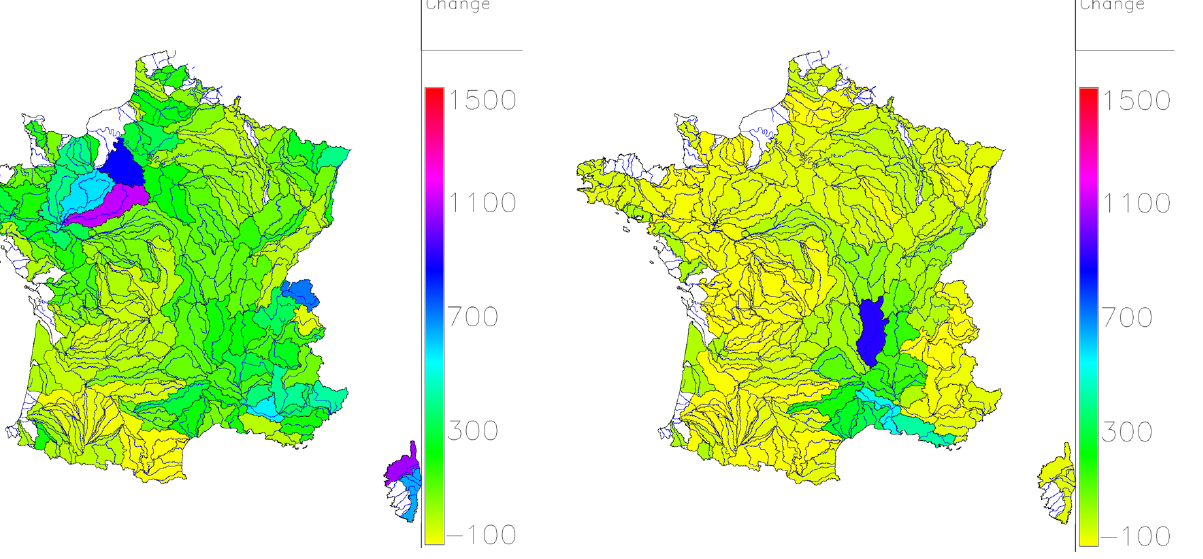
Fig. 7. The color of the areas correspond to changes in flood losses, in percent. The result presented here correspond to WTS scenario, comparing costs in 1970–1999 and 2069–2098; the loss-ratio as- sumption is based on the Var event